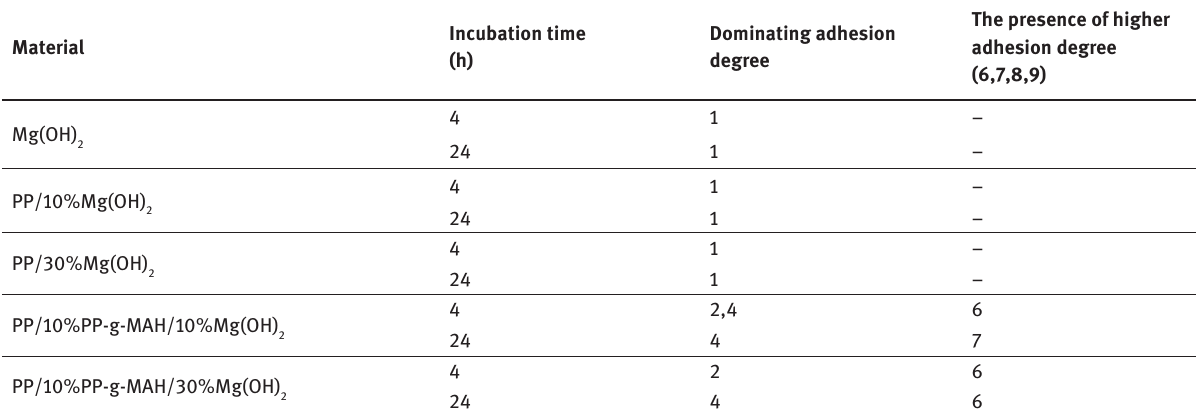
Table 4: Dominating and higher adhesion degrees of Pseudomonas aeruginosa to the composites surface.